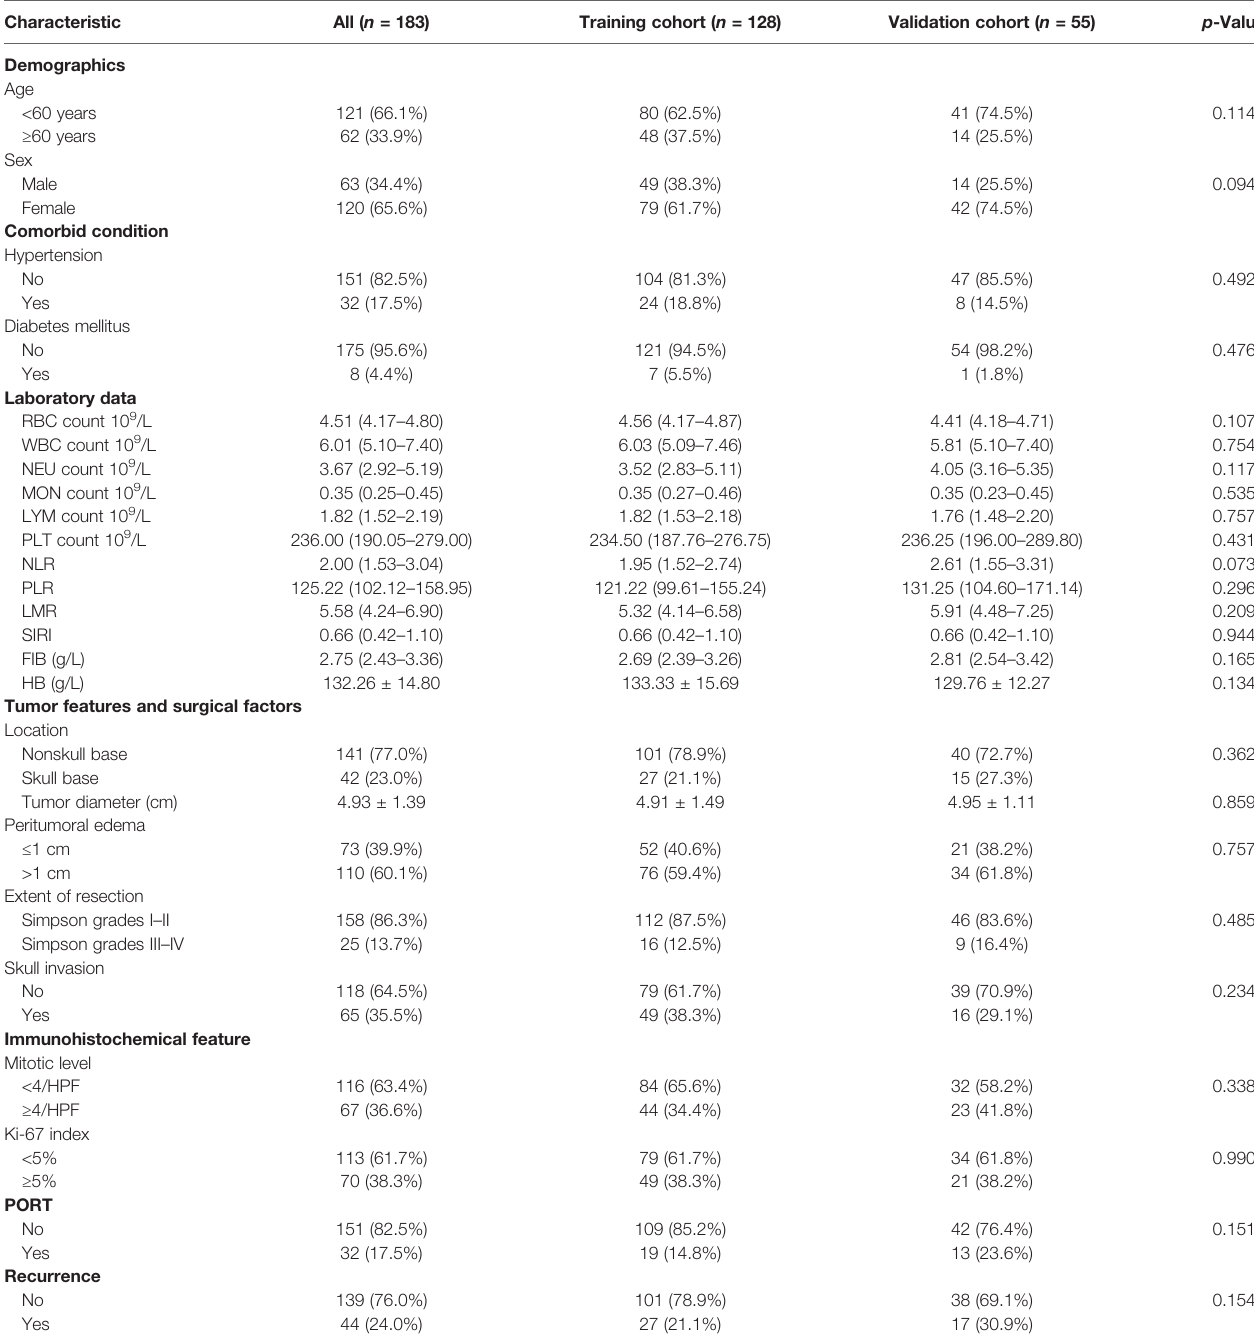
TABLE 1 | Characteristics of patients in the training and validation